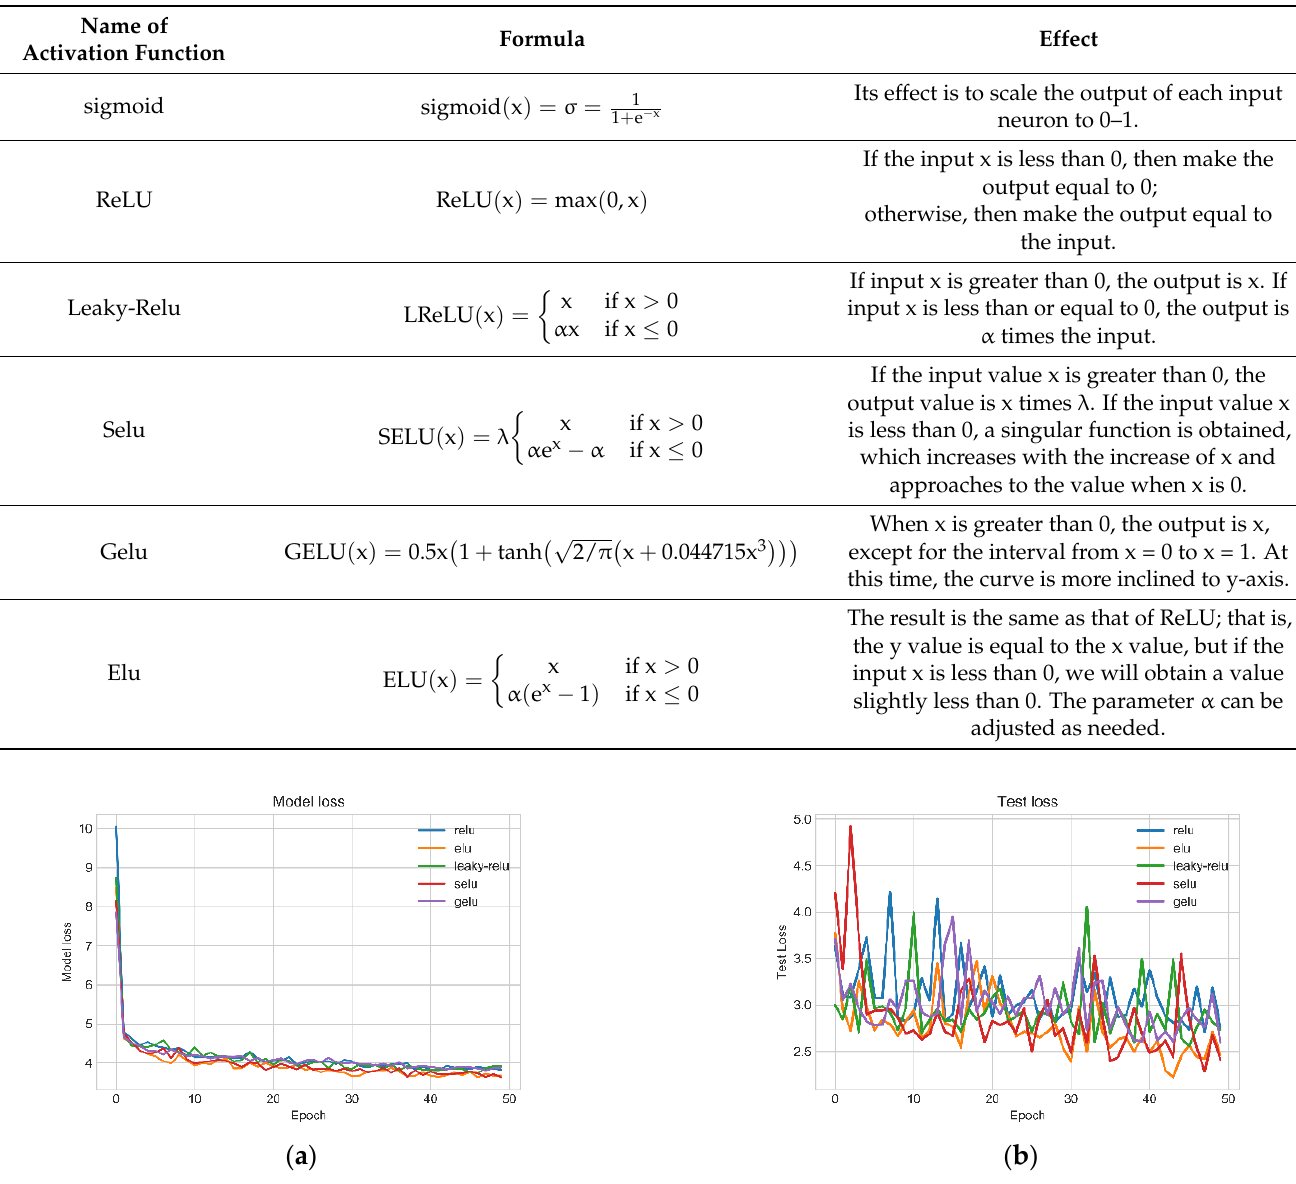
Table 2. Different activation function formulas and the effects. Figure 14. Images of different activation functions ( a ) and their derivatives ( b ).